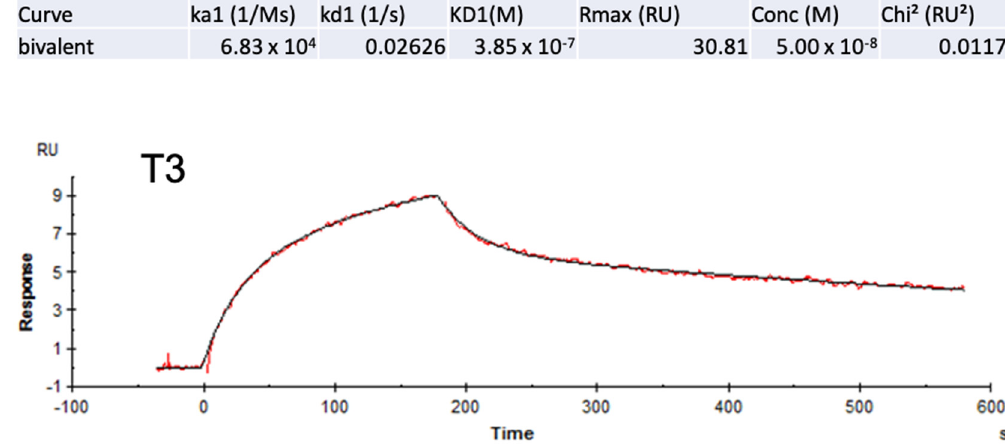
Figure A3 . SPR measurements of variant T3 at pH 7.0 (bivalent fit).